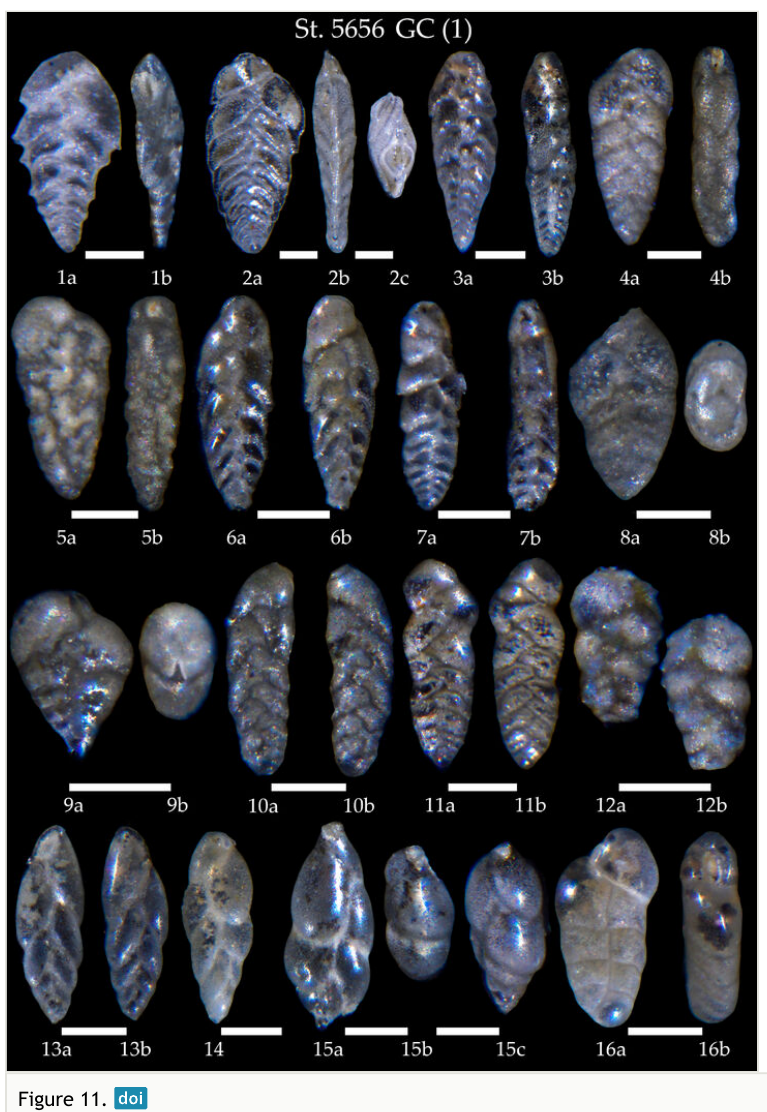
Figure 11. Station 5656 GC . 1 Brizalina pygmaea , a side view, b apertural view; 2 Brizalina alata , a, b side view, c apertural view; 3 Bolivina spathulata , a side view, b apertural view; 4 Bolivina striatula , a side view, b apertural view; 5 Bolivina pseudoplicata , a side view, b apertural view; 6 Bolivina earlandi , a side view, b lateral view; 7 Bolivinellina pseudopunctata , a side view, b apertural view; 8 Bolivina albatrossi , a side view, b apertural view; 9 Bolivina inflata , a side view, b apertural view; 10 Bolivina limbata , a side view, b lateral view; 11 Bolivina sp., a side view, b lateral view; 12 Bolivina subspinescens , a side view, b lateral view; 13,14 Fursenkoina complanata , 13a apertural view, 13b side view; 15 Fursenkoina fusiformis , a side view, b, c apertural view; 16 Fursenkoina texturata , a side view, b apertural view. Scale 100